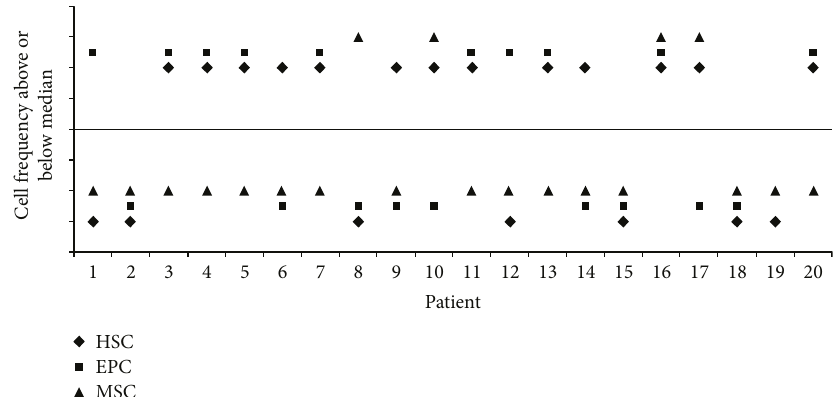
Figure 5: Qualitative individual evaluation of frequencies in the three stem cell compartments. Frequencies were determined by the colony assay in IHD (1 to 12) and VHD (13 to 20) samples. Results of the three colony assays were individually assessed in 20 patients to compare for the occurrence of frequencies higher or lower than the median. In this qualitative analysis, the line represents the median frequency of colony assays, and individual colony frequencies are displayed above or below the corresponding